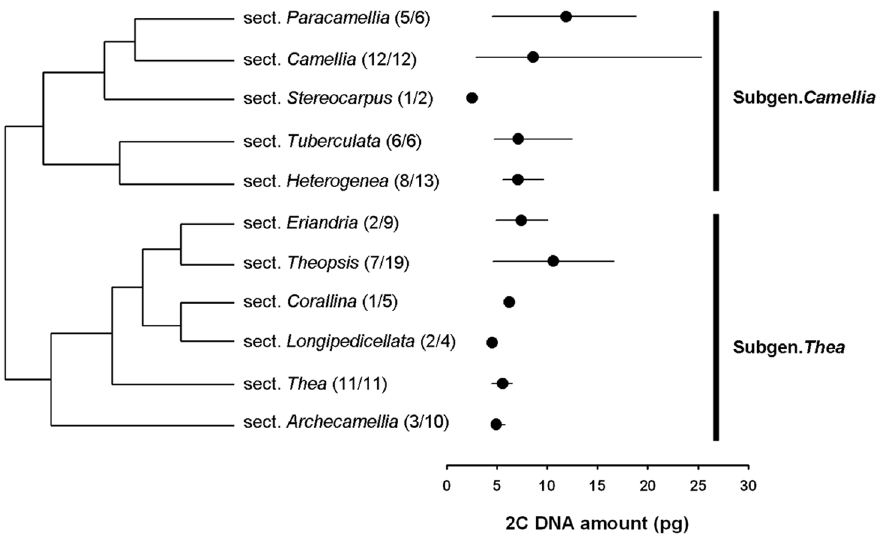
Figure 6. Nuclear DNA contents and evolutionary relationships among members of the genus Camellia . The indicated phylogenetic relationships of the genus were constructed by using morphological data and adopted from Min et al. [28]. The numbers in brackets for each section N represent the number of species with the measured nuclear DNA content followed by the total number of species comprising the section. The mean for each section, while the range is shown as a line from the minimum to maximum 2C DNA amounts. The two 2C DNA amount is indicated by subgenera recognized in Camellia are given on the right side of the figure.